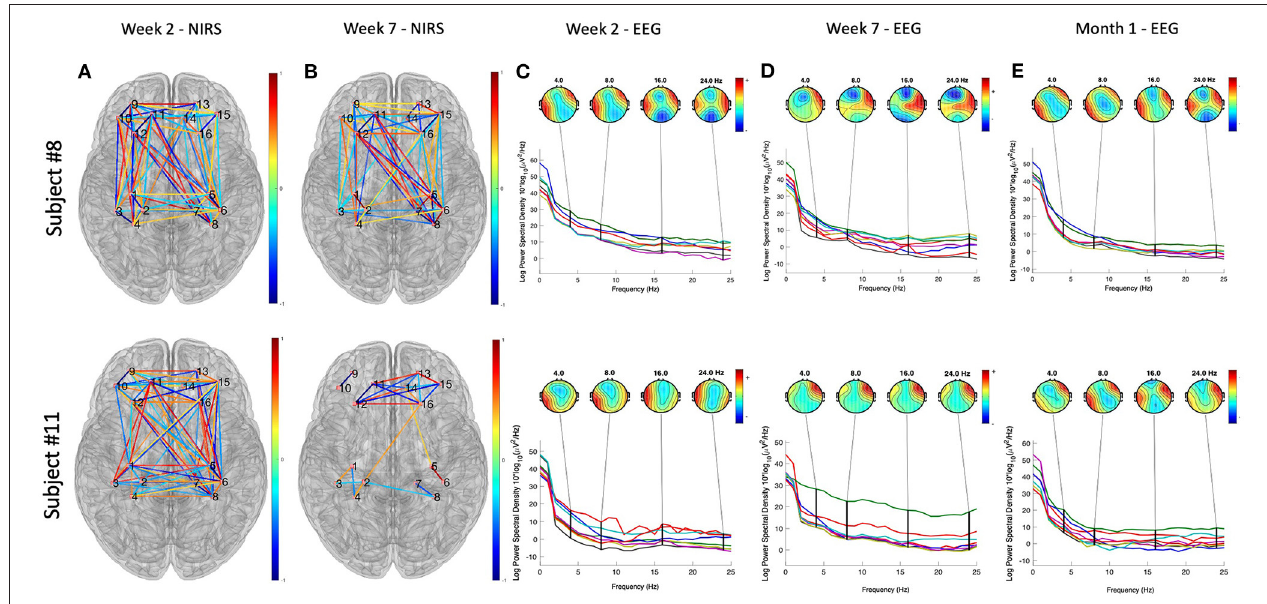
FIGURE 5 | Neuroimaging data analysis results of the resting state before tDCS stimulation at week 2, week 7, and 1-month follow-up, respectively, for subjects #8 and #11. (A,B) Show the significant connections between bilateral prefrontal and sensory cortices revealed by the fNIRS data ( p < 0.05, FDR corrected) in week 2 and week 7. The color bar represent the correlation coefficient levels, ranges from − 1 to 1. (C–E) Demonstrate the power spectra map of EEG data, separately at 4/8/16/24Hz, in week 2, week 7, and month 1 follow-up. The color bars represent the power of the spectral density at different frequencies, ranges from 0 to 60.